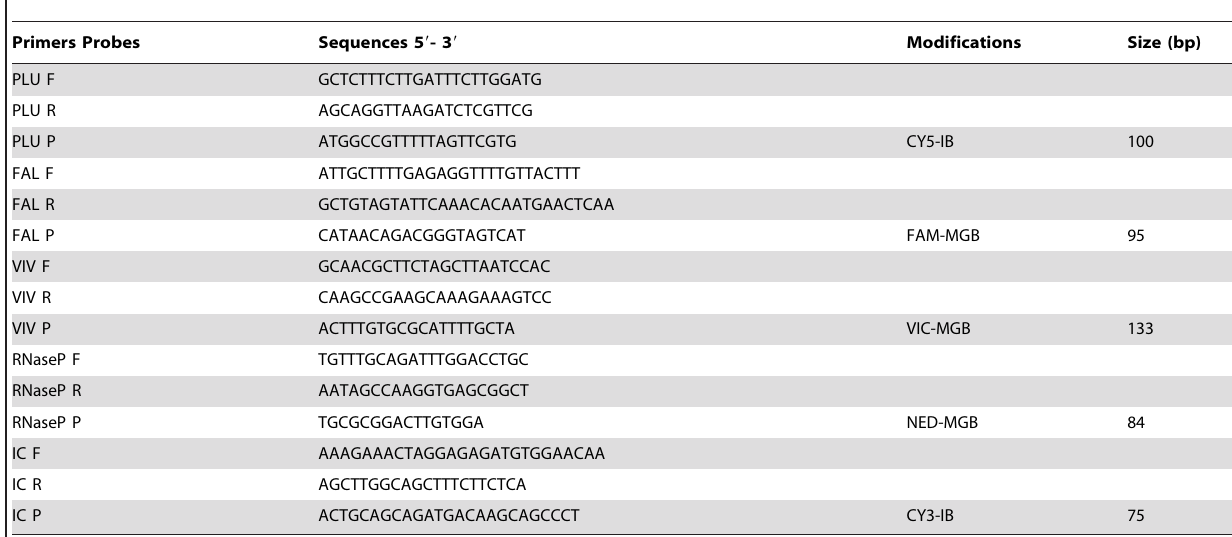
Table 1. Primers and probes sequences used for qPCR assays in this